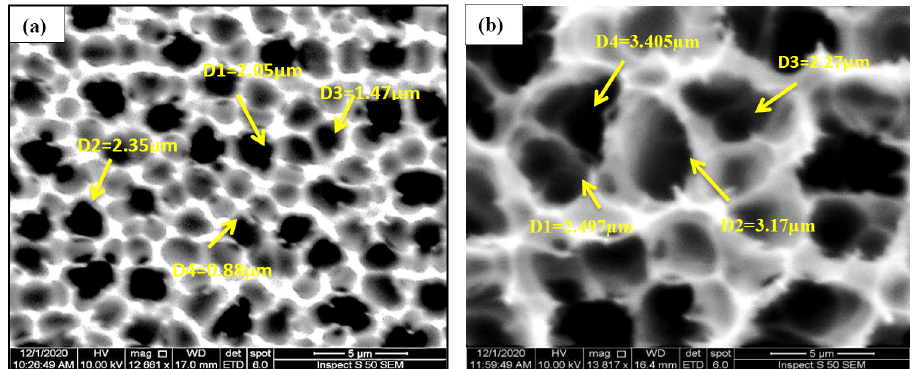
Figure 3: SEM images of PS at different etching current densities (a) 12 and (b) 30mA/cm 2 , etching time 10min. and HFc 40%.